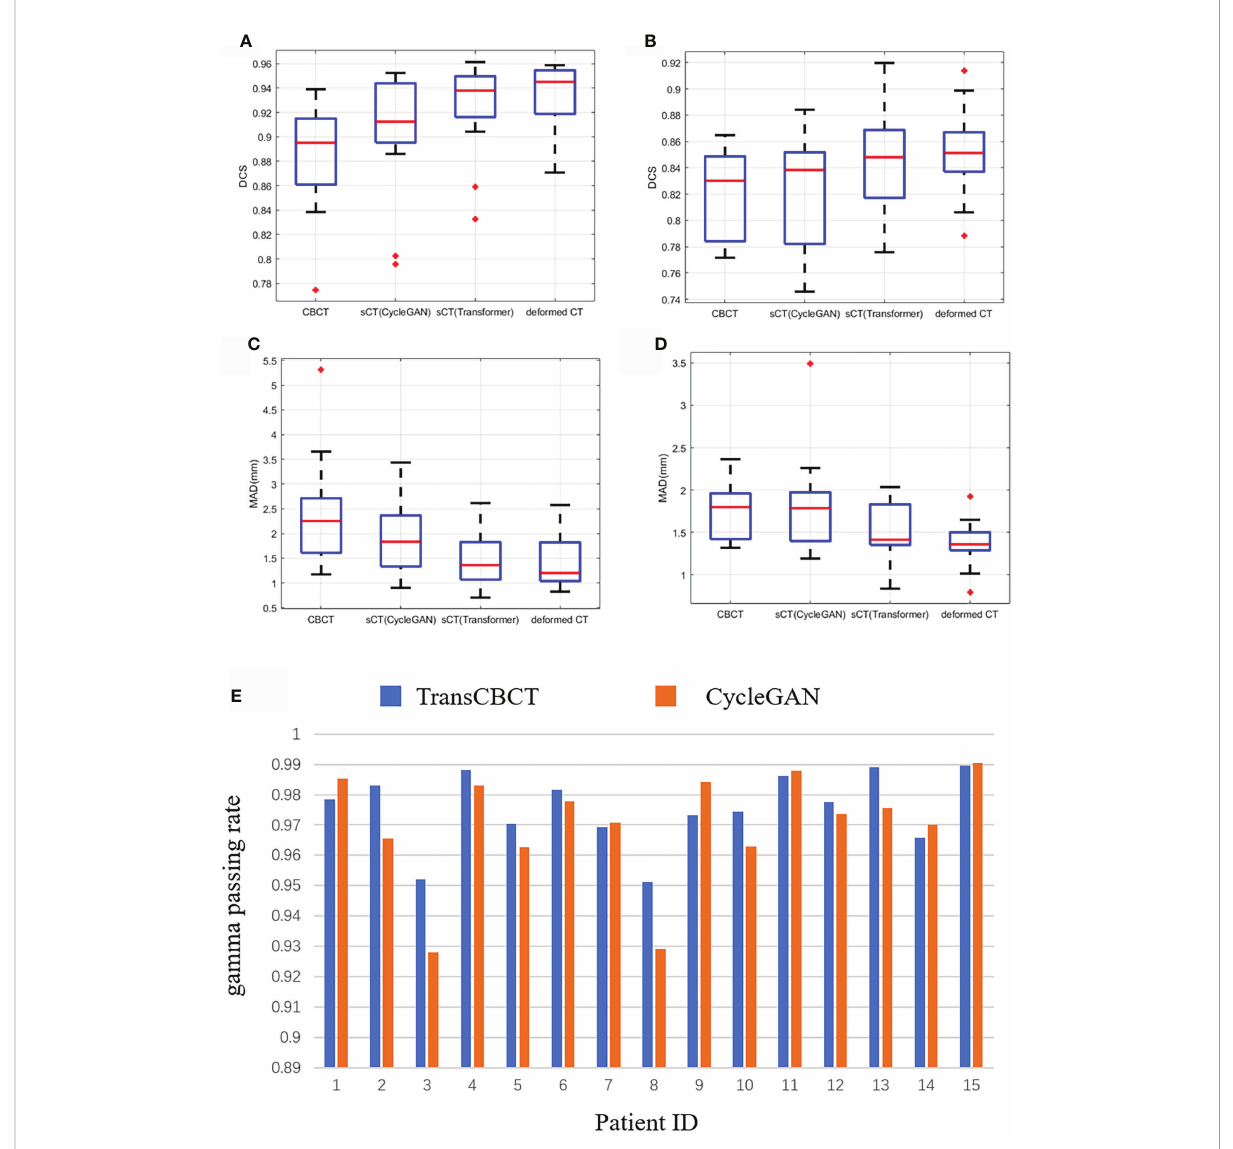
FIGURE 5 Statistical analysis of clinical value based on ART need. (A – E) Result of auto-segmentation. (A) DSC of bladder. The p -values were <0.05 (CBCT vs. deformed CT), <0.05 [sCT(CycleGAN) vs. deformed CT], and 0.196 [sCT(TransCBCT) vs. deformed CT]. (B) DSC of rectum. The p -values were <0.05 (CBCT vs. deformed CT), <0.05 [sCT(CycleGAN) vs. deformed CT], and 0.144 [sCT(TransCBCT) vs. deformed CT]. (C) MAD of bladder. The p -values were <0.05 (CBCT vs. deformed CT), <0.05 [sCT(CycleGAN) vs. deformed CT], and 0.450 [sCT(TransCBCT) vs. deformed CT]. (D) MAD of rectum. The p -values were <0.05 (CBCT vs. deformed CT), <0.05 [sCT(CycleGAN) vs. deformed CT], and 0.058 [sCT(TransCBCT) vs. deformed CT]. (E) Result of gamma passing rate for 15 patients. The results of TransCBCT were more robust compared to the CycleGAN. Some of CycleGAN results were under